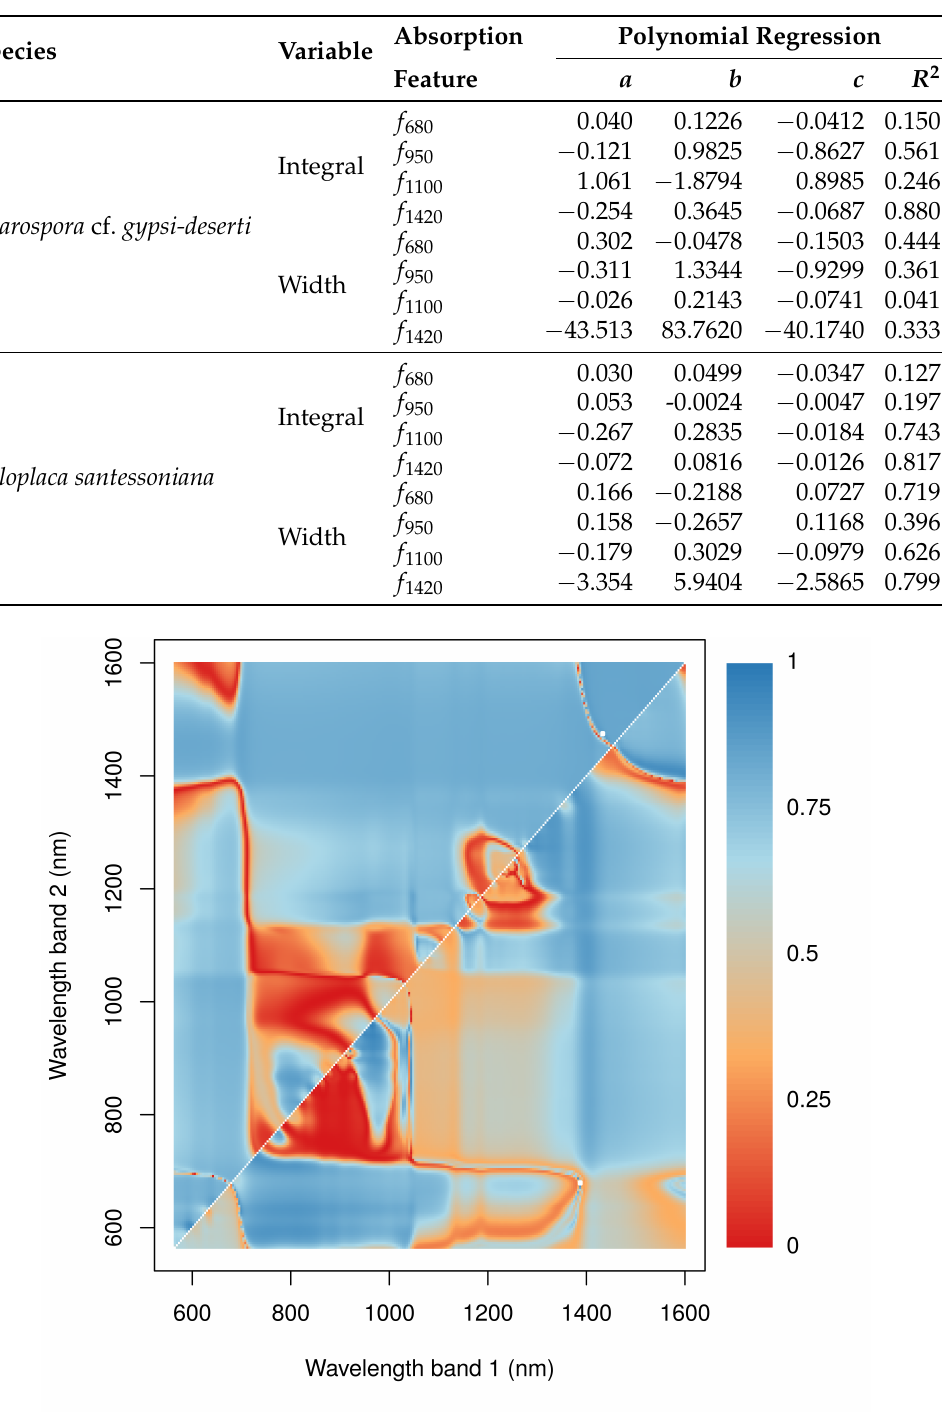
Figure 5. Relationship between NP of Acarospora cf. gypsi-deserti (lower right portion of the graph) and Caloplaca santessoniana (upper left portion) and normalized ratio indices. Colors represent the R 2 -values of the regression models between NP and NRI λ values. λ 1 and λ 2 are indicated by the x- and 1 , λ 2 , norm y-axis. The white squares mark the position of the index that results in the highest R 2